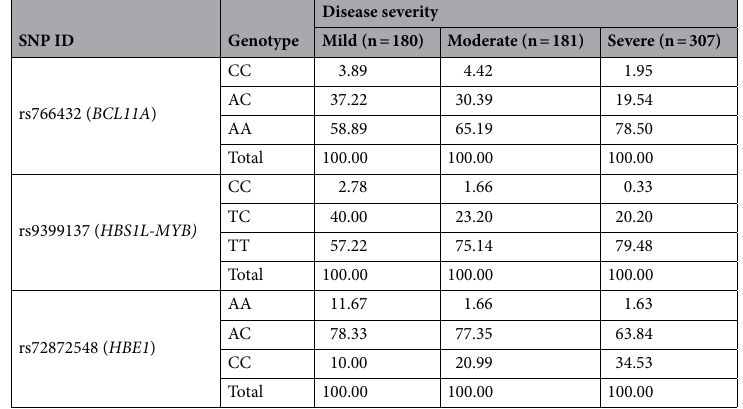
Table 3. Genotype frequencies of predictive SNPs among mild, moderate and severe β 0 -thalassemia/HbE patients in cohort 1.